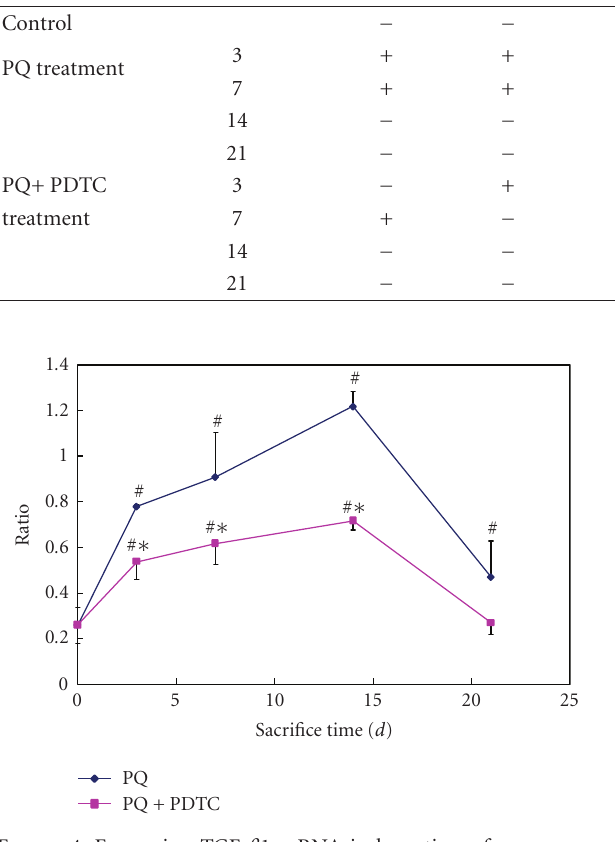
Figure 4: Expression TGF- β 1 mRNA in lung tissue from groups of the control, PQ treatment, and PQ + PDTC treatment. Relative TGF- β 1 mRNA abundance was normalized with the β -actin, and expressed as relative units. Values are given as mean ± SE ( n = 3). # Compared with the control, P < . 05; ∗ compared with the PQ treatment, P < . 05.